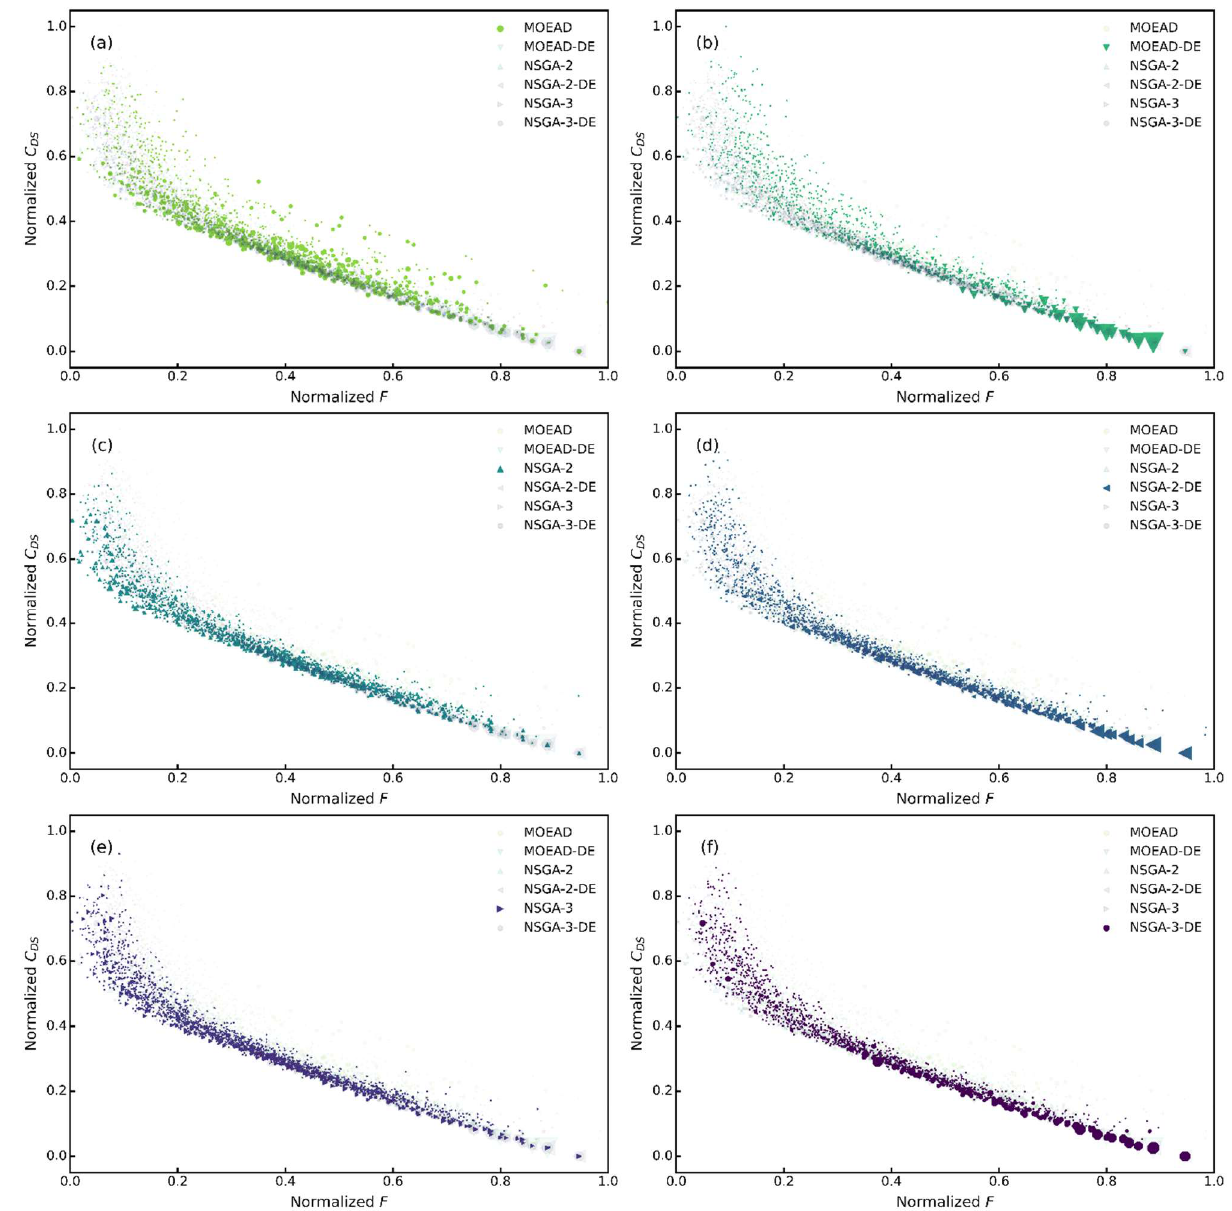
Figure 9. Non-dominated fronts. ( a ) MOEAD; ( b ) MOEAD-DE; ( c ) NSGA-II; ( d ) NSGA-II-DE; ( e ) NSGA-III; ( f ) NSGA-III-DE.